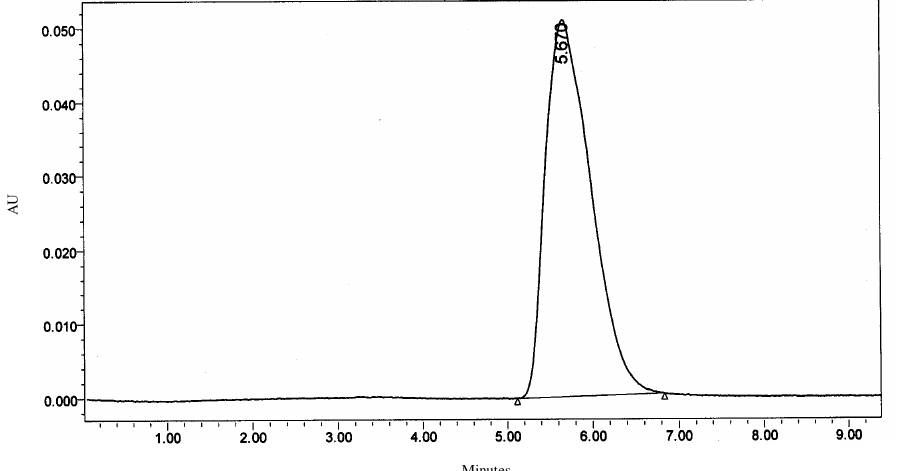
Figure 5a. Typical HPLC chromatogram of standard